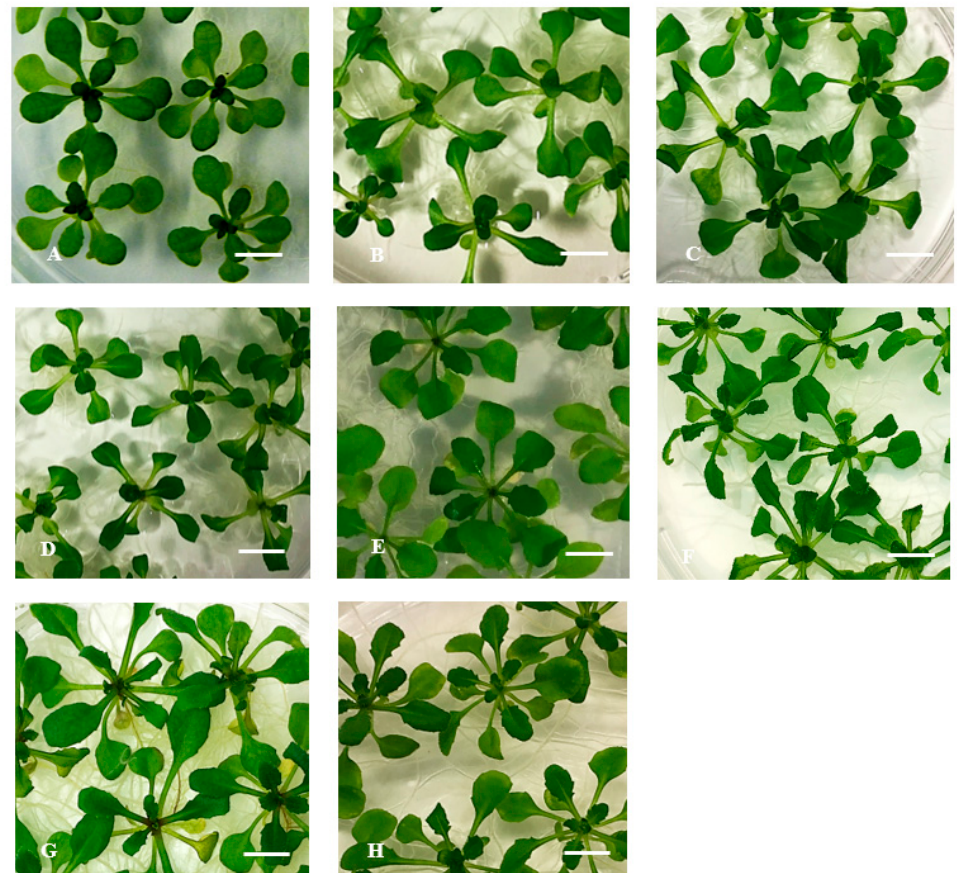
Figure 4. Development of HH on Arabidopsis thaliana less-lignin mutants ref3-1 and ref3-3 on p -coumaric acid after 14 days of culture. ( A ) Ler seedlings cultured on 0.7% Micro-agar (control), ( B – D ) ref3-1: ( B ) Seedling cultured on 0.7% ( w/v ) Micro-agar, ( C ) Seedling cultured on 0.4% ( w/v ) gelrite, and ( D ) Seedling cultured on 0.4% ( w/v ) gelrite + 100 µM p -coumaric acid. ( E ) Col-0 seedlings cultured on 0.7% Micro-agar (control), ( F – H ) ref3-3: ( F ) Seedling cultured on 0.7% ( w/v ) Micro-agar, ( G ) Seedling cultured on 0.4% ( w/v ) gelrite, and ( H ) Seedling cultured on 0.4% ( w/v ) gelrite + 100 µM p -coumaric acid. Bar = 5 mm.